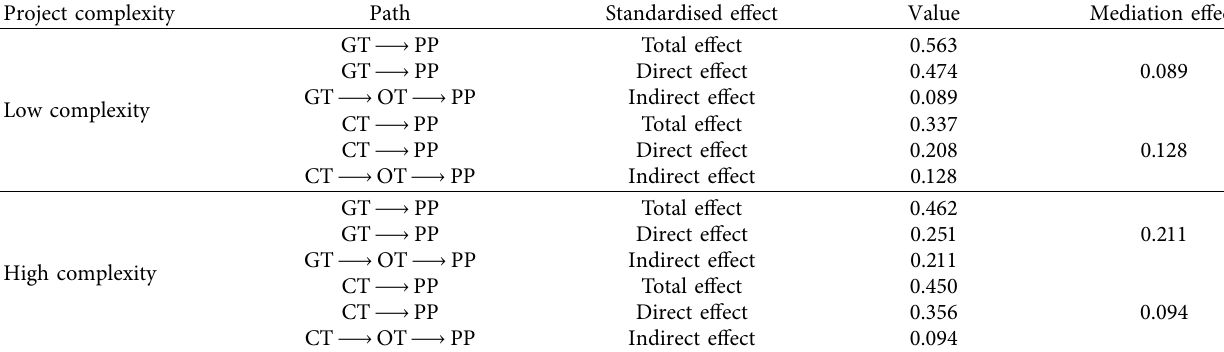
Table 8: The mediating role of opportunism.